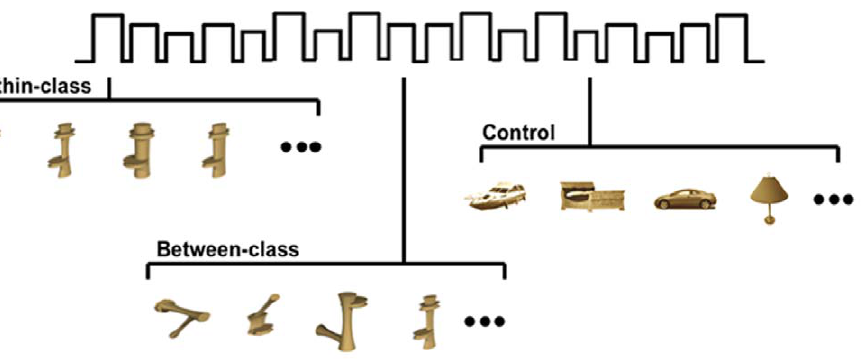
Figure 2. An example scan of the fMRI pre- and post-training scans. In the within-class discrimination condition, each block contained only Ziggerins within the same class, thus requiring within-class/subordinate-level discrimination. In the between-class discrimination condition, each block contained Ziggerins from different classes, thus requiring between-class/basic-level discrimination. The control blocks contained familiar objects from different categories.